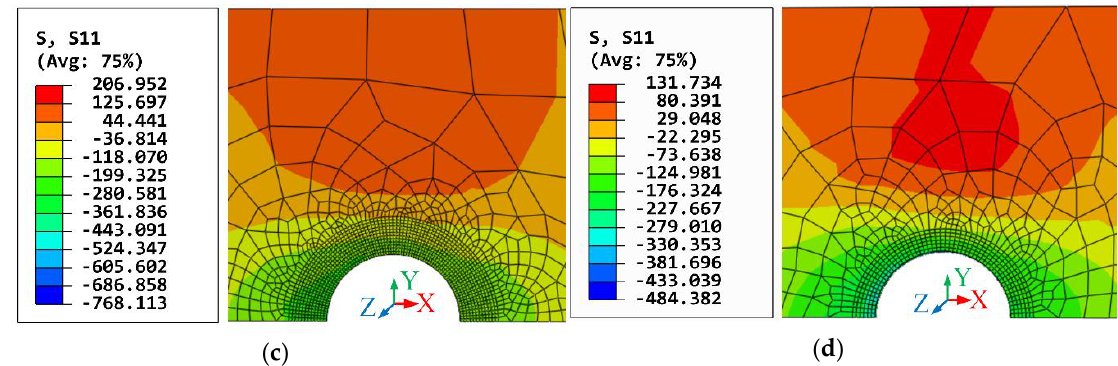
Figure 12. The residual stress distribution of plates: ( a ) The lower surface of the upper plate with 4 mm diameter rivet; ( b ) the upper surface of the lower plate with 4 mm diameter rivet; ( c ) the lower surface of the upper plate with 5 mm diameter rivet; ( d ) the upper surface of the lower plate with 5 mm diameter rivet.